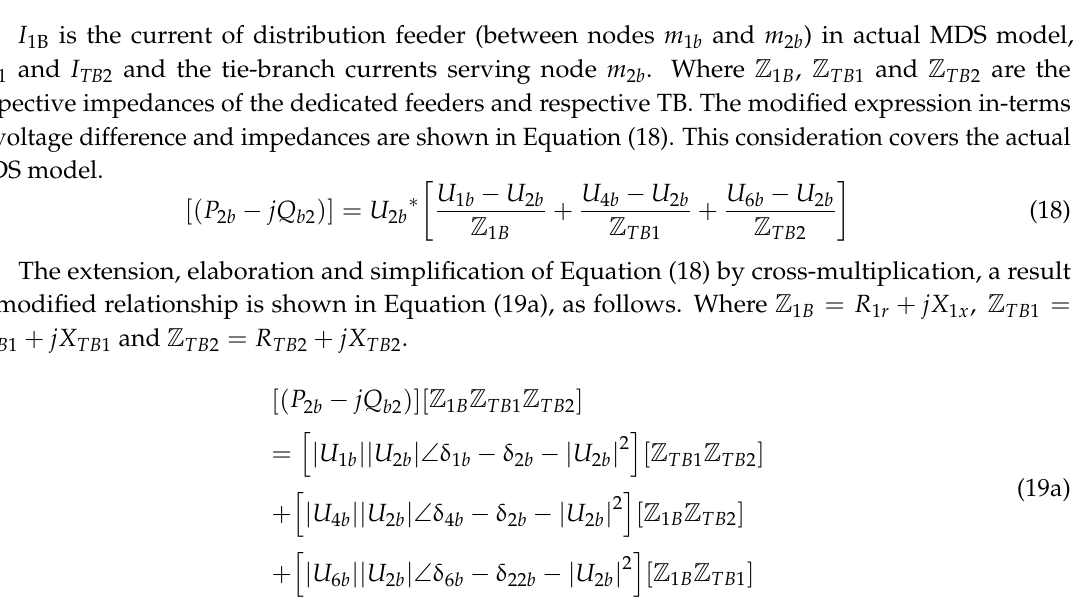
Figure 3. The electrical equivalent diagram of mesh distribution system under an actual case.